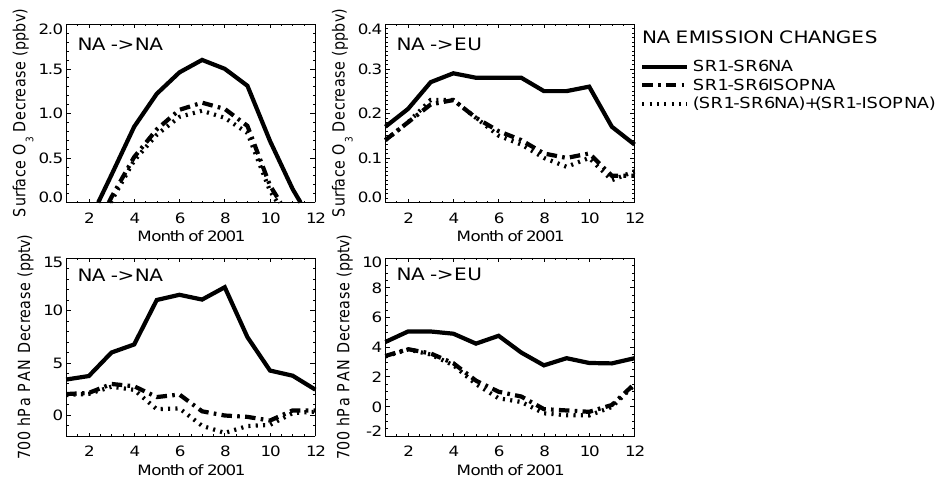
Fig. 5. Monthly mean regional (left) and intercontinental (right) 1 O 3 ANTH (solid; as in Fig. 4) and 1 O 3 ANTHISOP (dash-dot) in surface air (top), and 1 PAN ANTH (solid; as in Fig. 4) and 1 PAN ANTHISOP (dash-dot) at 700hPa (bottom), diagnosed as the difference between sensitivity simulations as in Fig. 4. Also shown are 1 O 3 ANTH+ 1 O 3 ISOP and 1 PAN ANTH+ 1 PAN ISOP